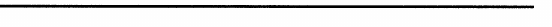
TABLE II Bernoulli hypothesis test for Weyerhauser data,